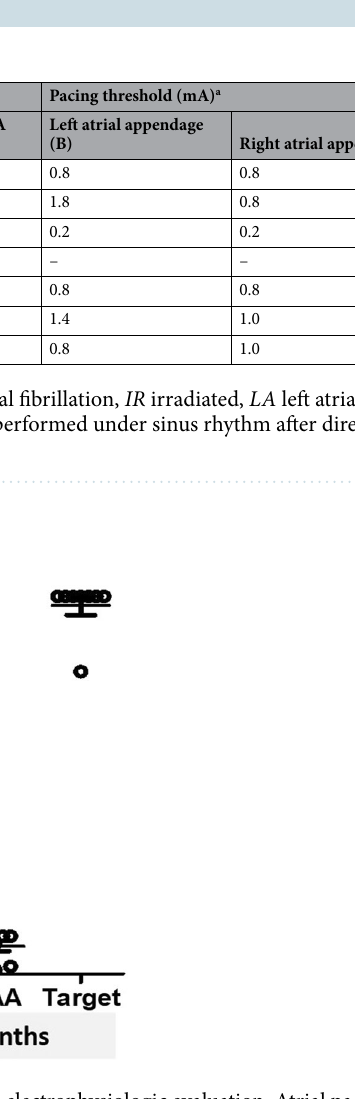
Figure 2. Post-radiotherapy cardiac rhythm and electrophysiologic evaluation. Atrial pacing tests confirmed that pacing was not captured inside the irradiated target area at 4 months. LAA left atrial appendage, RAA right atrial